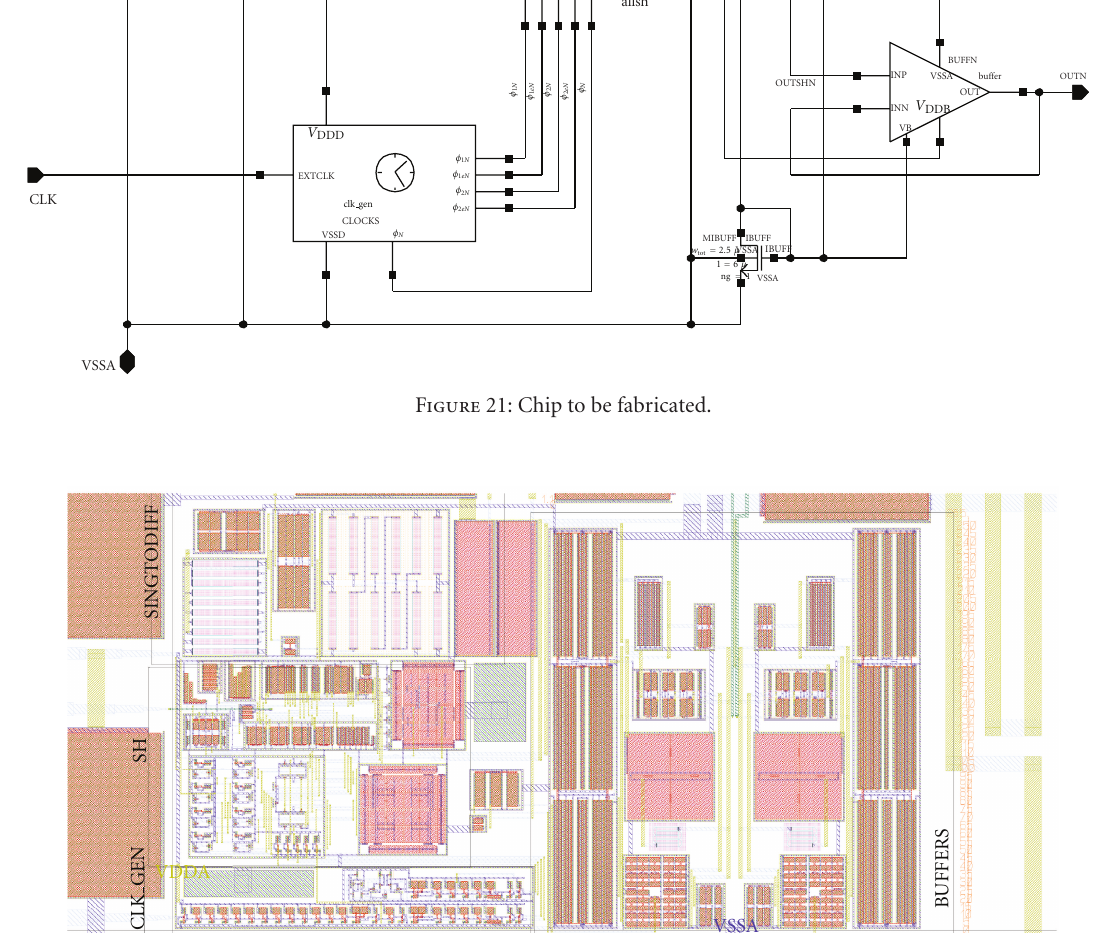
Figure 22: Core layout.